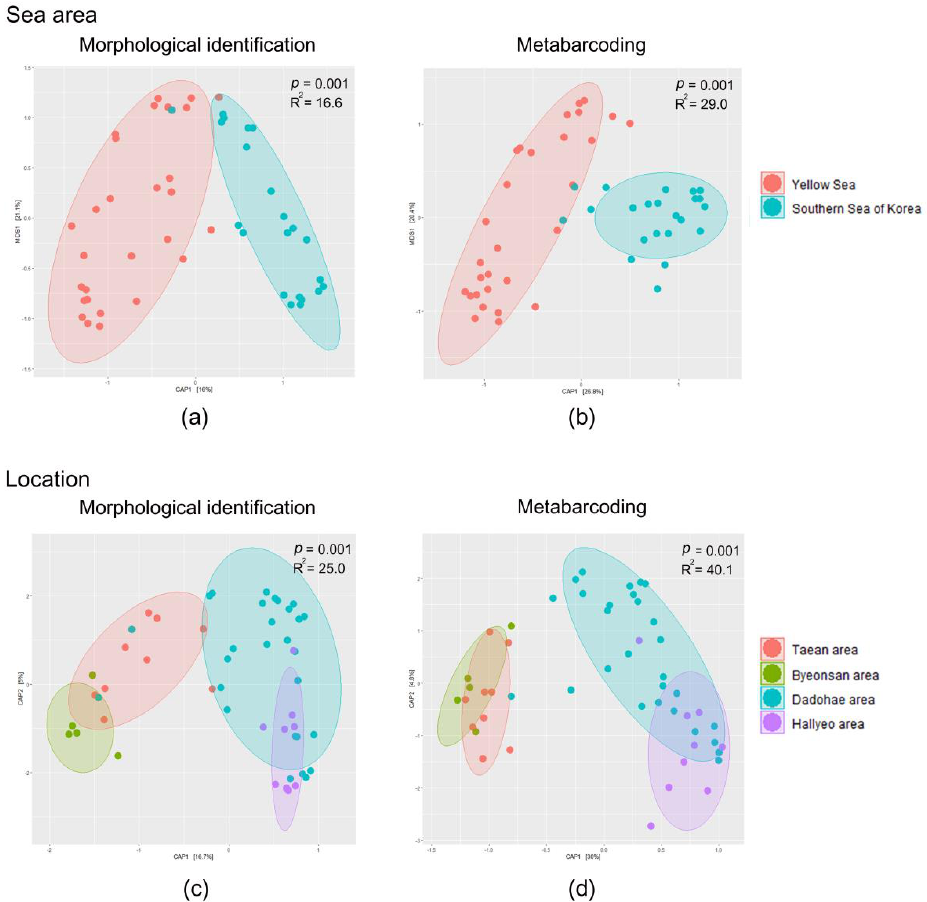
Figure 4. Constrained analysis of principal coordinates (CAP) plots for mesozooplankton communities identified using the morphological identification and metabarcoding methods. CAP analysis for mesozooplankton communities based on Bray–Curtis dissimilarities according to each category and identification method: ( a ) sea area and morphological identification, ( b ) sea area and metabarcoding, ( c ) location and morphological identification, and ( d ) location and